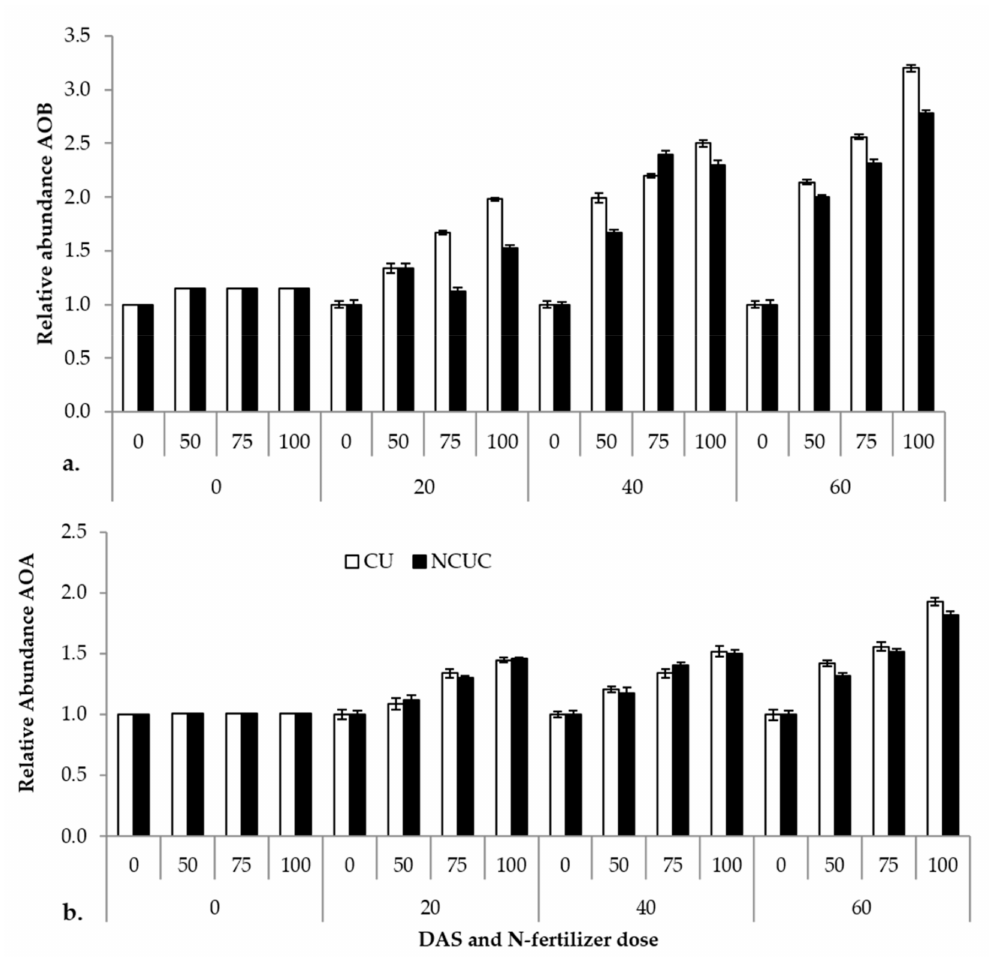
Figure 4. Effect of different types of fertilizer on relative abundance of soil ( a ) ammonia-oxidizing (AOB) and, ( b ) archaeal (AOA) bacteria in potato